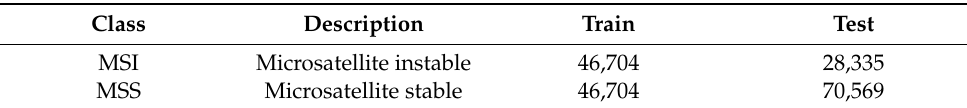
Table 4. The MSI vs. MSS dataset details.